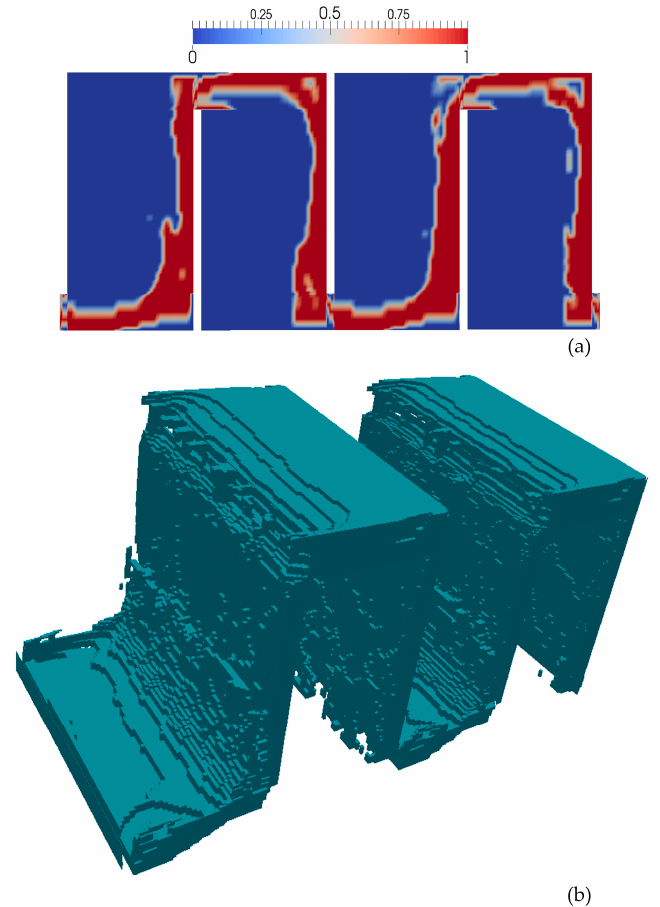
Figure 12. Visualization of jet region using a combination of vorticity gradient and flexion product for LES: ( a ) on the x – y plane at mid span ( z = L /2); ( b ) a three ‐ dimensional view of the jet regions of LES: ( a ) on the x – y plane at mid span ( z = L /2); ( b ) a three-dimensional view of the jet regions of each each chamber in the mixing tank. chamber in the mixing